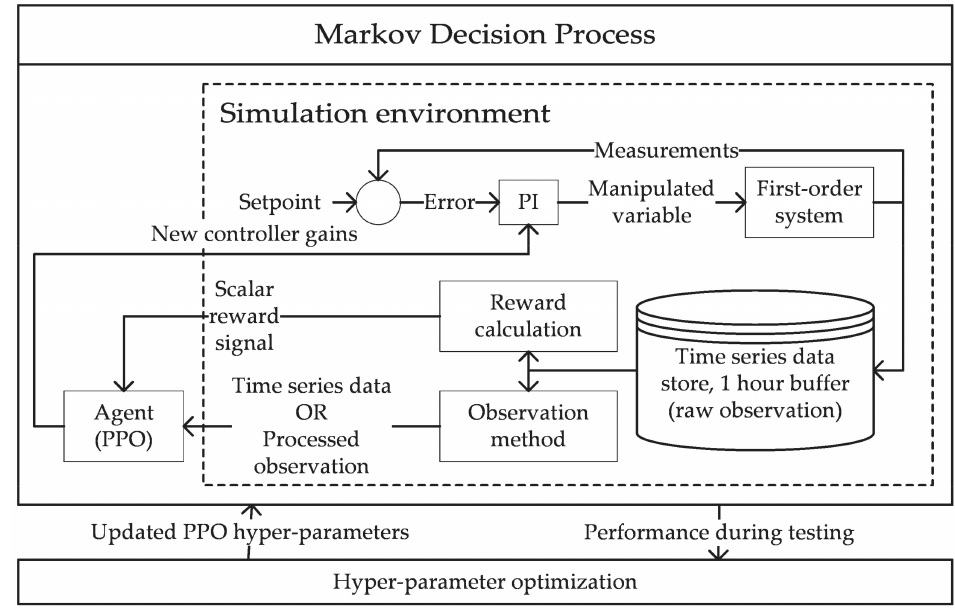
Figure 1. Block diagram of the system showing the simulation environment, data processing, agent, and hyper-parameter optimization